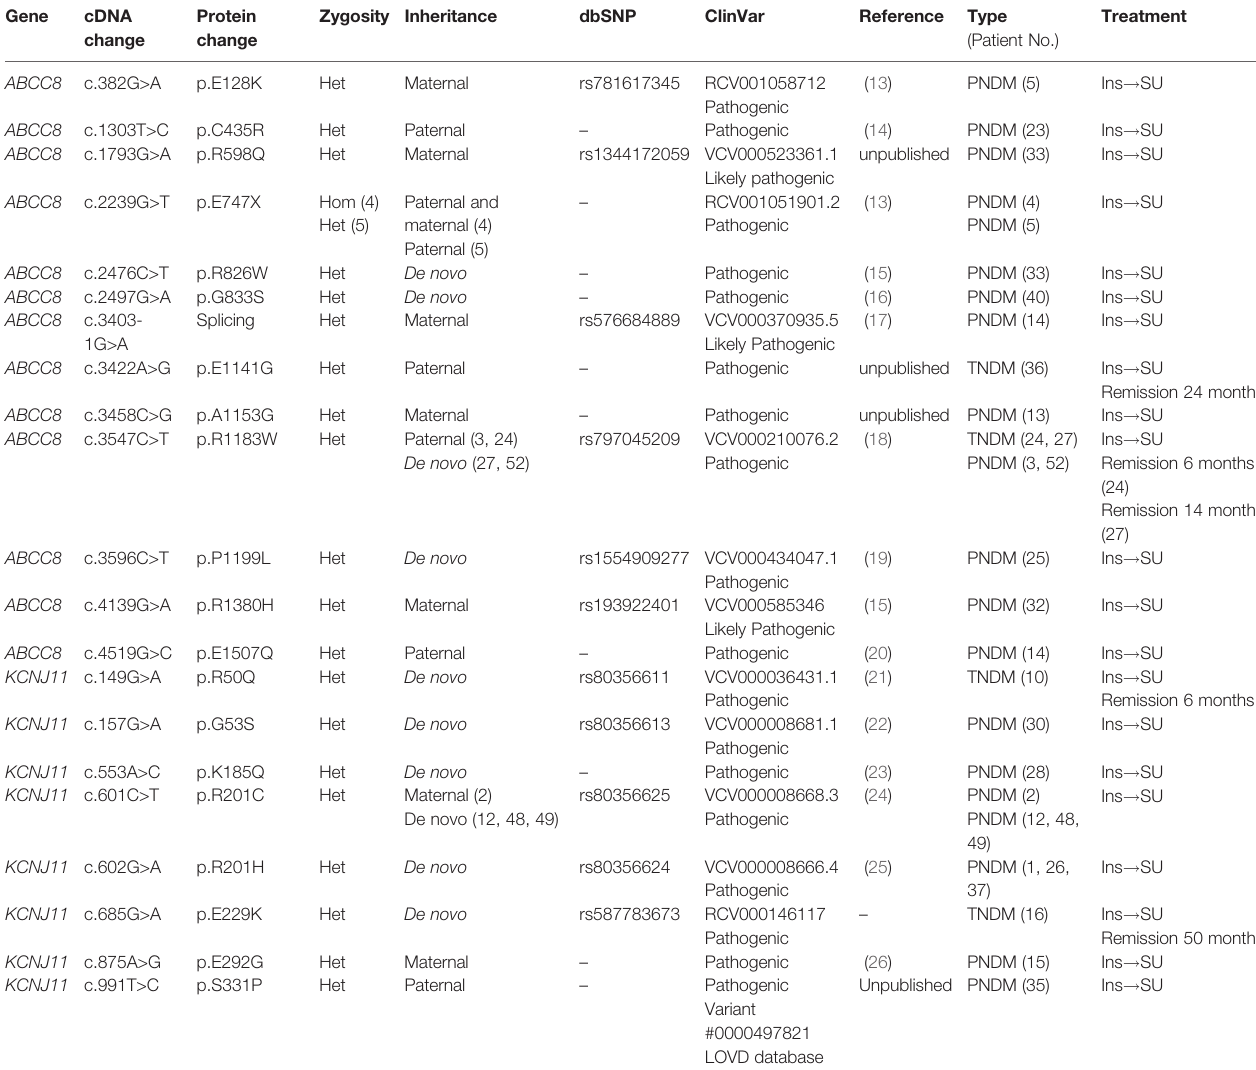
TABLE 2 | Molecular analyses of 27 Vietnamese patients with